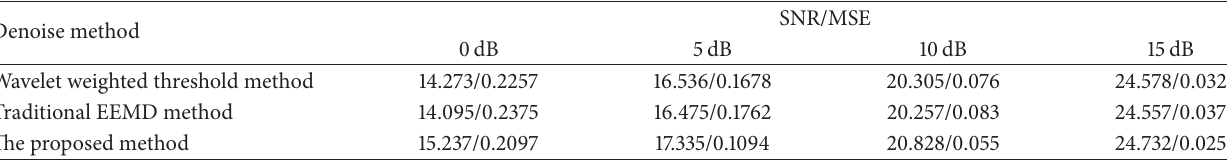
Table 1: Denoising results of Lorenz time